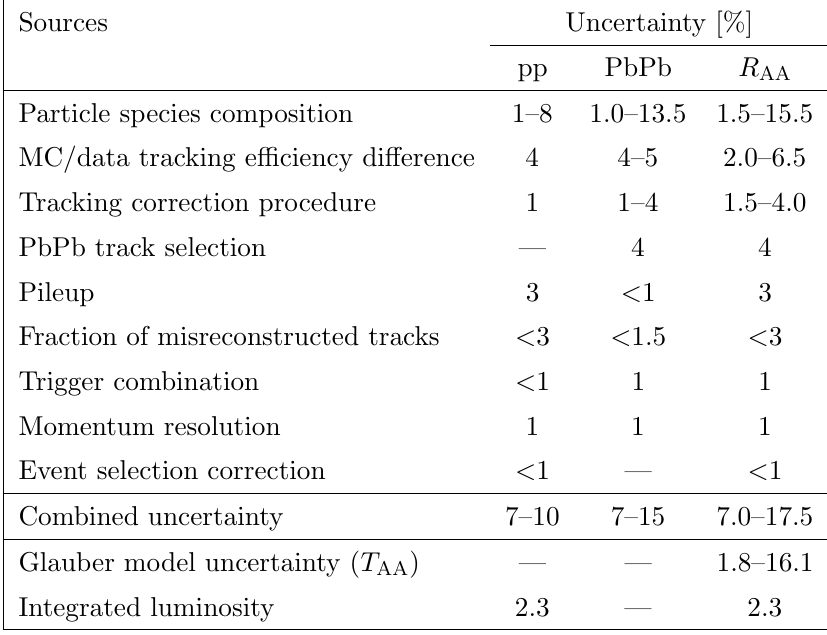
Table 3 . Systematic uncertainties associated with the measurement of the charged-particle spectra p and R AA using s NN = 5 : 02 TeV pp and PbPb collision data. The ranges quoted cover both the p T and the centrality dependence of the uncertainties. The combined uncertainty in R AA does not include the integrated luminosity and the T AA